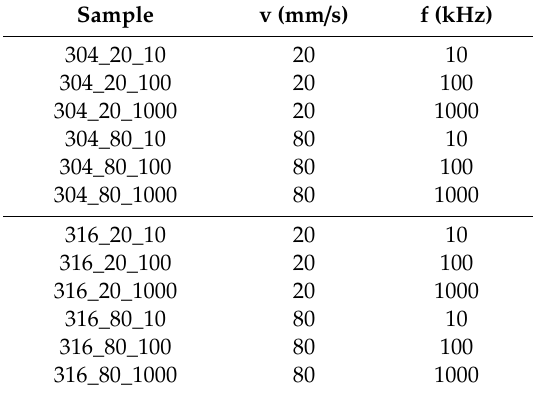
Table 2. Laser marking process parameters (v—scanning speed, f—pulse repetition rate).